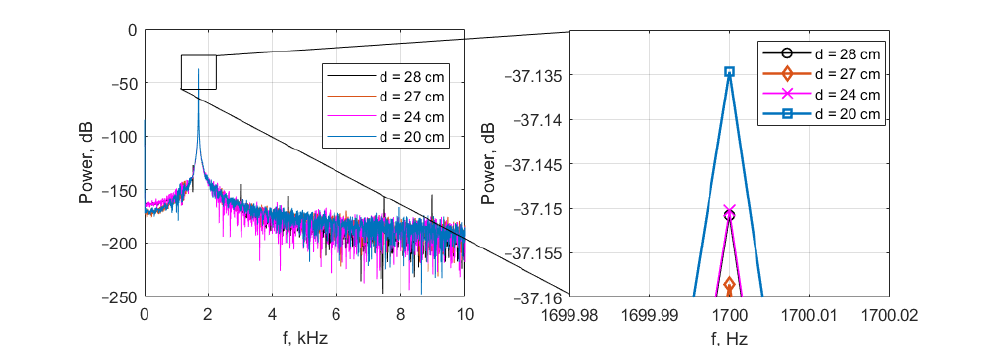
Figure 22. Spectra of differential amplifier outputs at different distances. One may see that only at distance d = 20 cm does the signal energy slightly increase, which indicates that the differential amplifier has detected the receiving coils unbalancing.